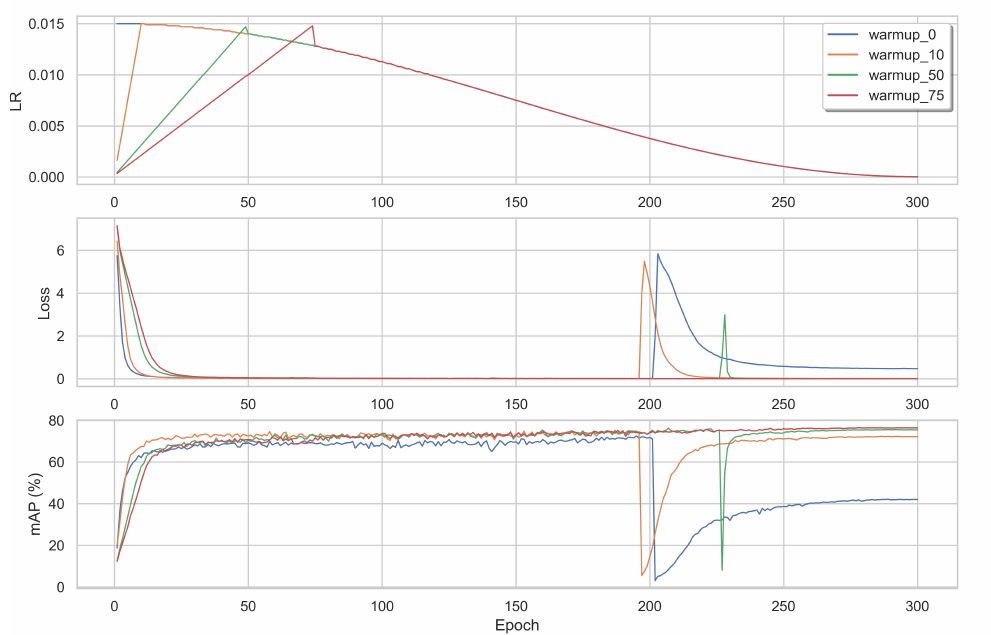
Figure 16. The mAP, loss, and learning rate per epoch when training D3 using the three losses and the BNNeck. The learning rate is linearly warmed up with different numbers of epochs until reaching LR base = 0.0150. The LR is then decayed using cosine annealing for 300 epochs.